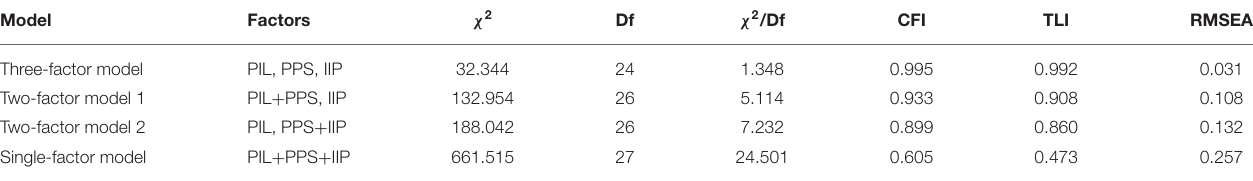
TABLE 2 | Results of confirmatory factor analysis.